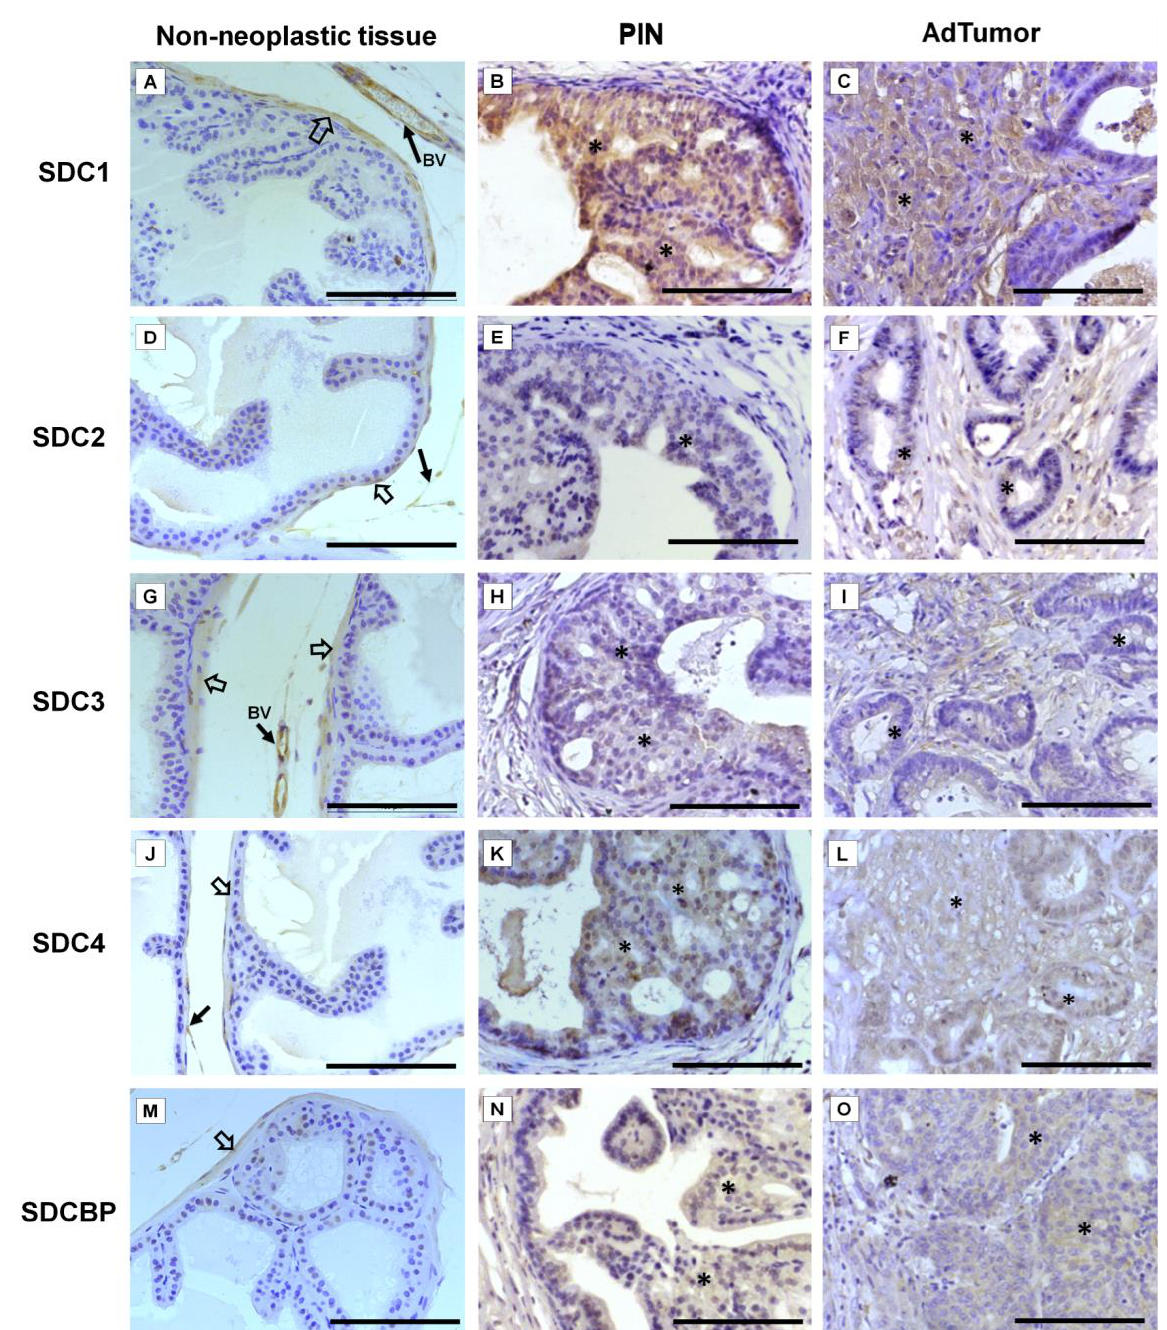
(Figure 4E) and strong cytoplasmic and pericellular immunostaining in Gleason 4–5 tumors (Figure 4F). No immunostaining for SDC2 was observed in the glandular stroma.